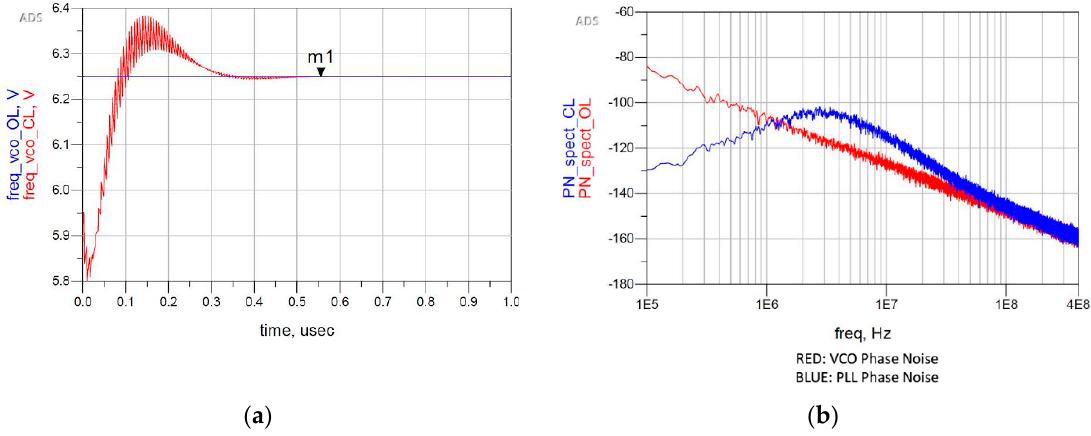
Figure 5. Results of the envelope analysis performed on the model of Figure 4: ( a ) locking process of the PLL; ( b ) comparison between the phase noise of the VCO and the phase noise of the closed loop PLL, considering the noise contribution of the VCO and the Loop Filter.